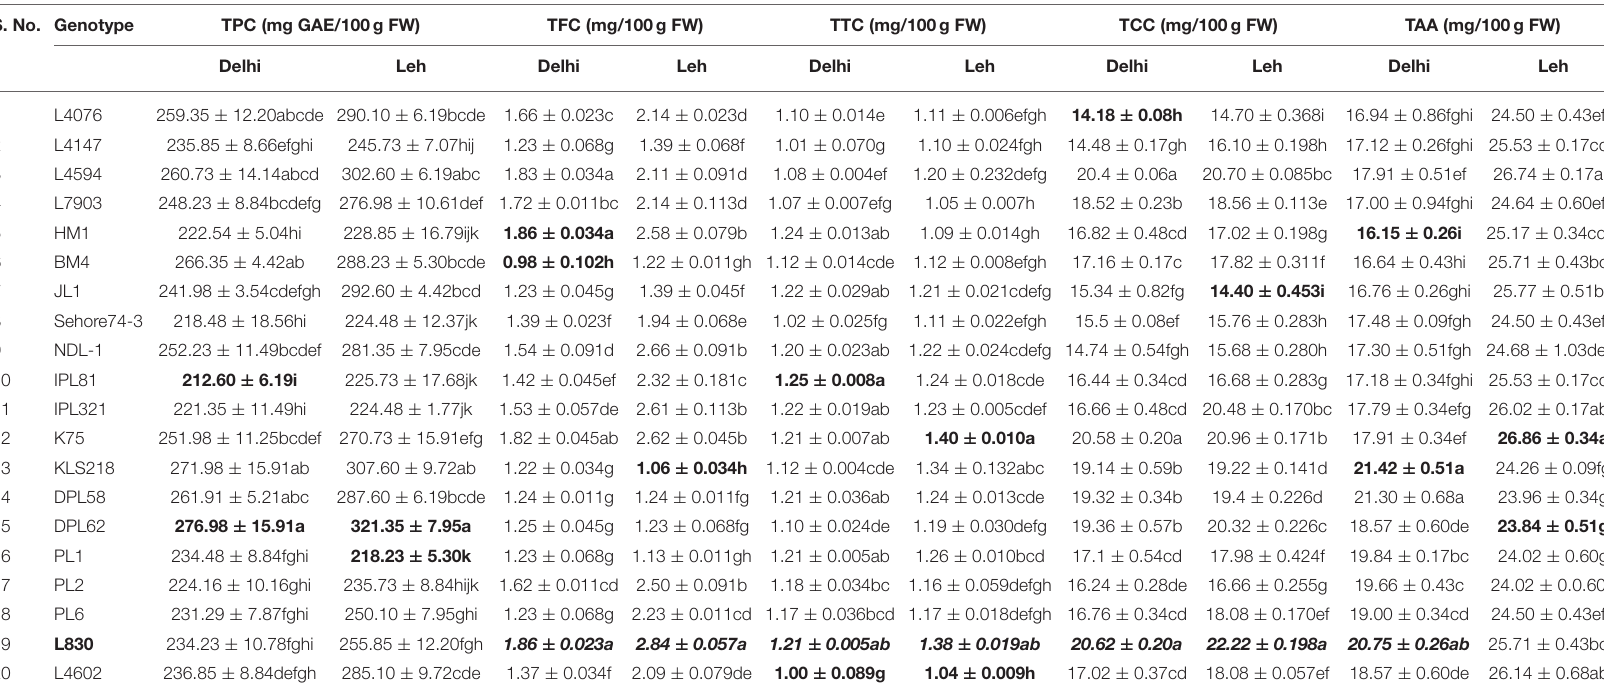
TABLE 2 | Mean concentration of total phenolics, flavonoids, carotenoids, tocopherols, and ascorbic acid in lentil microgreens grown under Delhi and Leh